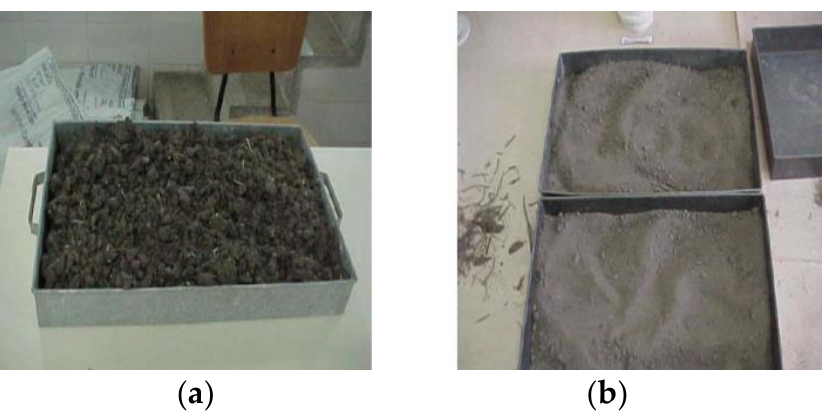
Figure 1. ( a ) Dry sludge and ( b ) sieved sludge obtained from a STP. The results presented in Table 1 show that the sludge used meets the heavy metal limits defined by the Resolution of the National Environment Council Conama 375/06 [31].